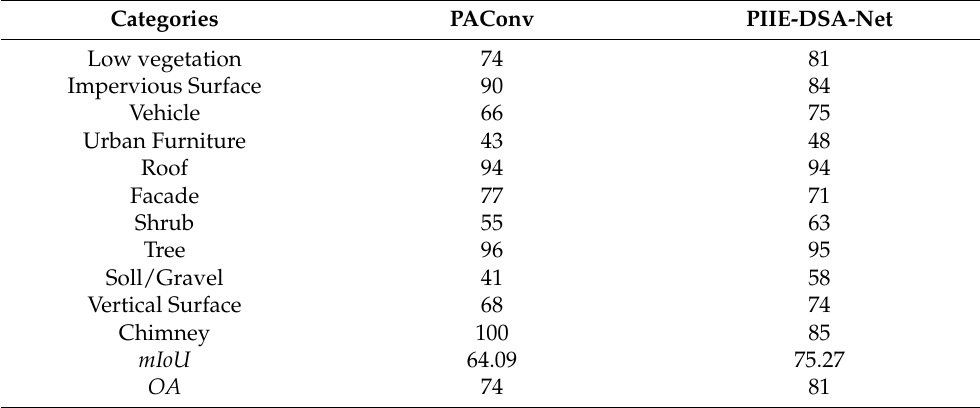
Table 7. The experiments on the H3D dataset